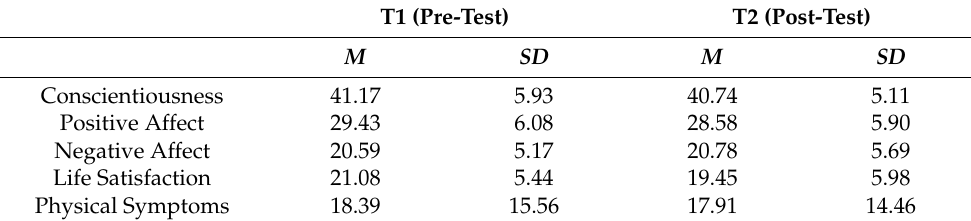
Table 2. Means and standard deviations for the key variables ( N =